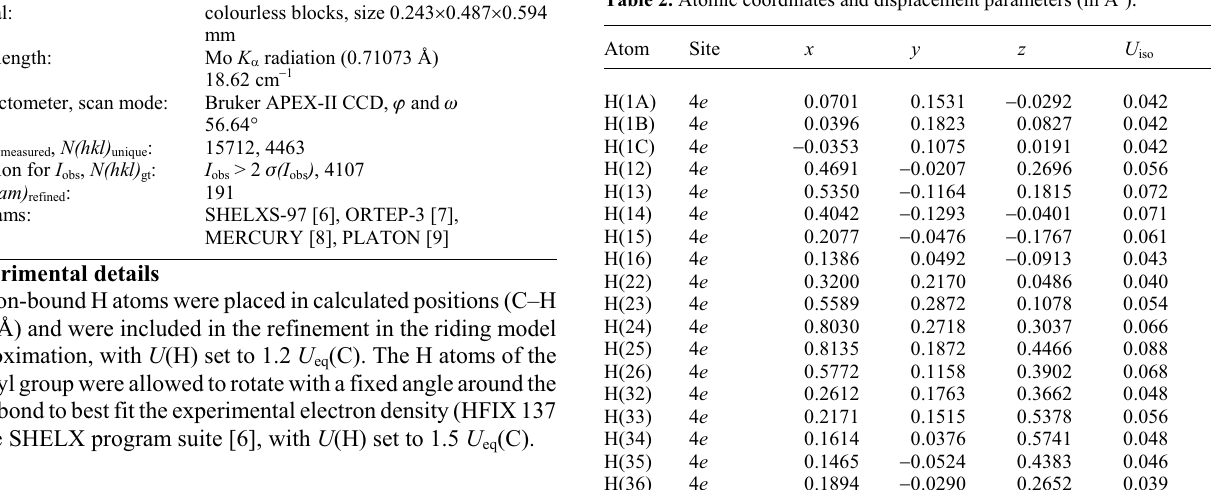
Table 2. Atomic coordinates and displacement parameters (in Å 2 )